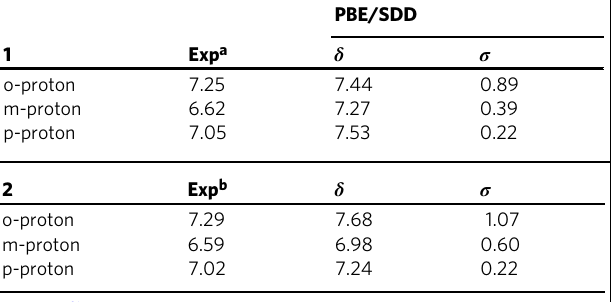
Table 1 Experimental and DFT 1 H NMR chemical shift δ and standard deviation σ in ppm of ligand protons in clusters 1 and 2 (PBE xc functional and SDD pseudopotential).